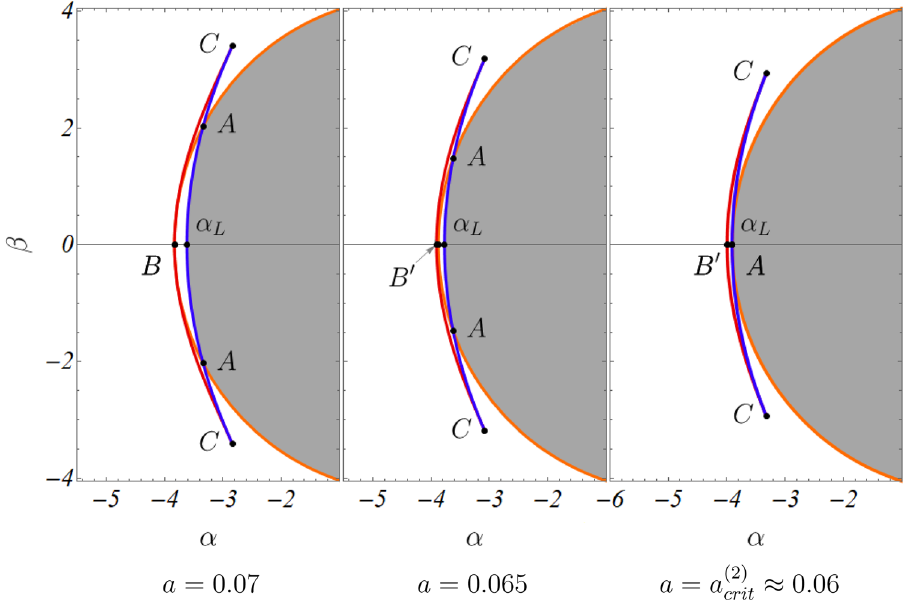
which is determined by Eq. (16) for β = 0. These critical values of the spin parameter delimit rotation rate ranges with qualitatively different features of the spherical photon orbits.